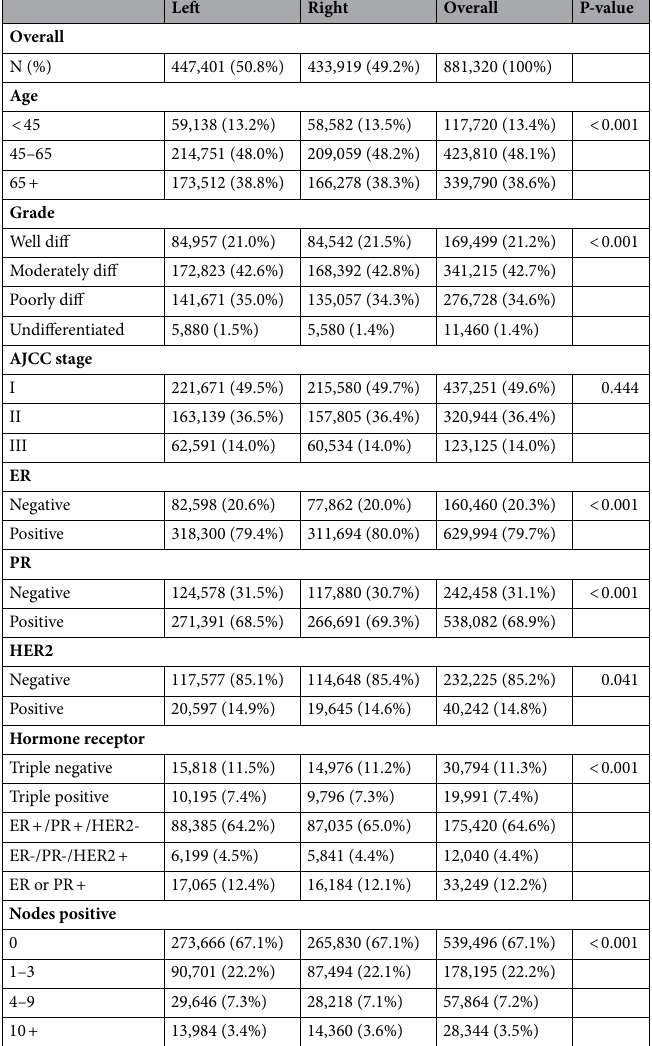
Table 1. The Surveillance, Epidemiology, and End Results (SEER) program: baseline characteristics based on laterality. ER estrogen receptor, PR progesterone receptor, HER2 human epidermal growth factor receptor 2, AJCC American Joint Committee on Cancer, Min minimum, Max